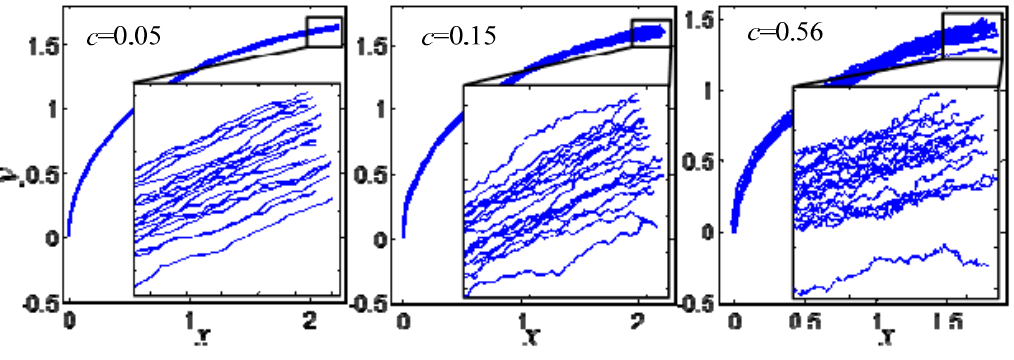
Figure 2. Growth of growth cone under different intensities of random motion.